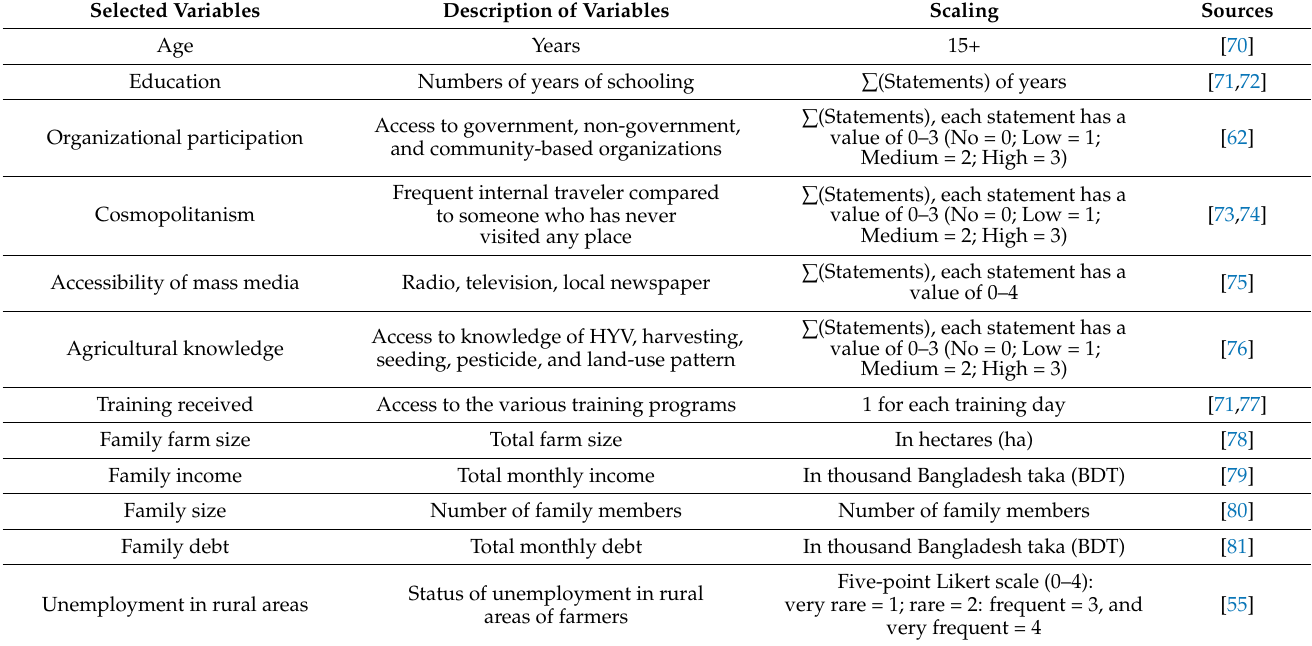
Table 1. Description of selected variables and sources for assessing farmers’ rural–urban